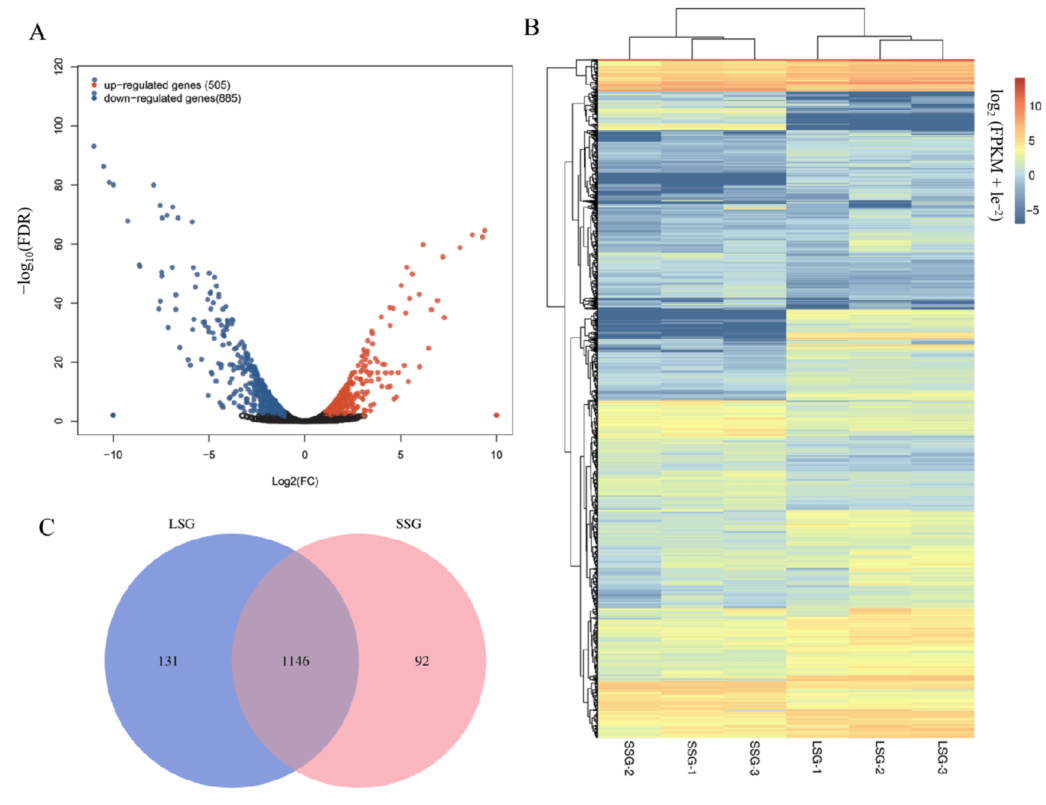
Figure 2. Analysis of DEGs between LSG and SSG. ( A ) Volcano map representing the number of DEGs between LSG and SSG. ( B ) Heat map of DEGs between LSG and SSG; the heat map of DEGs was analyzed using log 2 (FPKM + le − 2 ) at https://www.omicstudio.cn/index (accessed